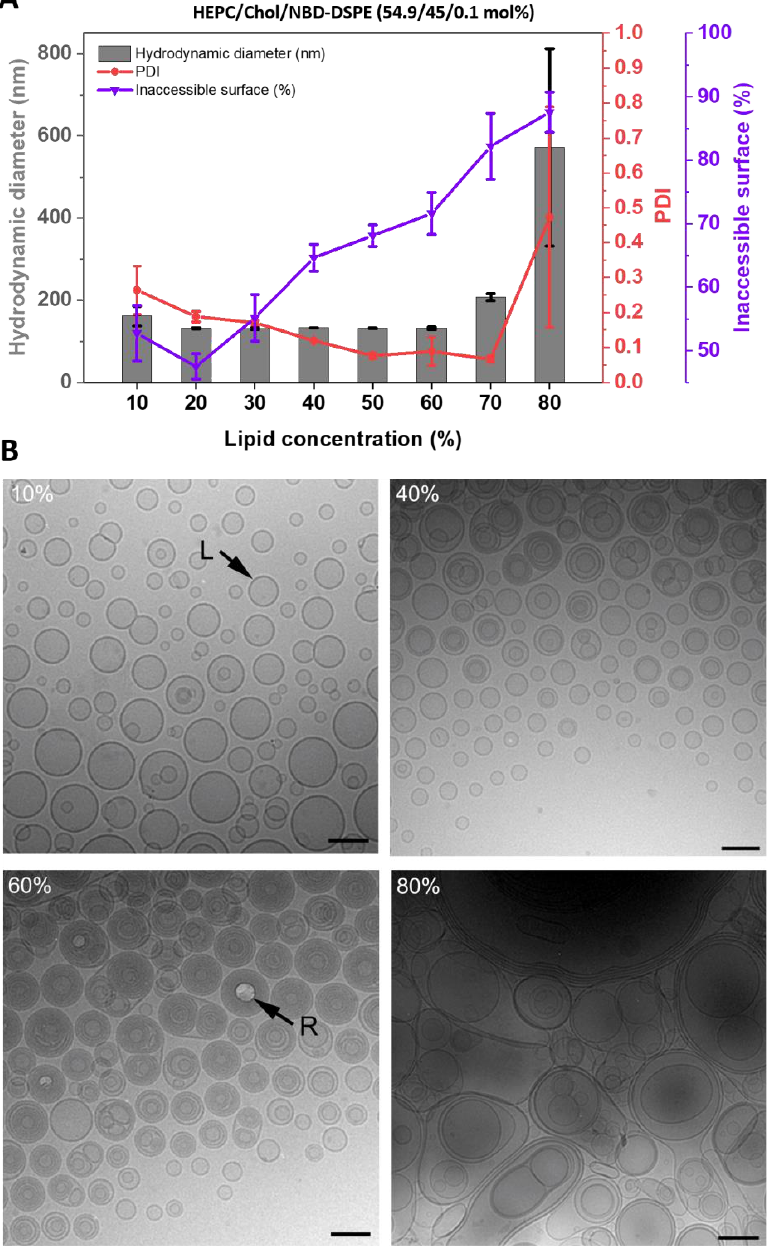
Figure 2. ( A ): Inaccessible surface, hydrodynamic diameter, and PDI depending on the lipid concentration used for the DC-homogenization of HEPC/Chol/NBD-DSPE 54.9/45/0.1) (mol%) lipid/buffer mixture; the resulting liposomes were measured by a fluorescence-based IAS-assay and DLS. Liposomes were prepared by DC at 2350 rpm, for 30 min, and at 20 °C, and redispersed by DC at 1500 rpm, for 2 min, and at 20 °C with TRIS buffer. Data are shown as the mean ± SD (n = 3). ( B ): Cryo-EM images of the liposome formulations shown in the IAS-assay figure above but without the headgroup-labeled fluorescence marker NBD-DSPE. Cryo-EM images of HEPC/Chol 55/45 (mol%) consisting of liposomes prepared by DC at 10%, 40%, 60%, and 80% lipid concentrations (VPG). Arrows denoted (L) indicate liposomes and those labeled (R) indicate radiation damage due to multiple layers containing liposomes. Scale bar = 100 nm.